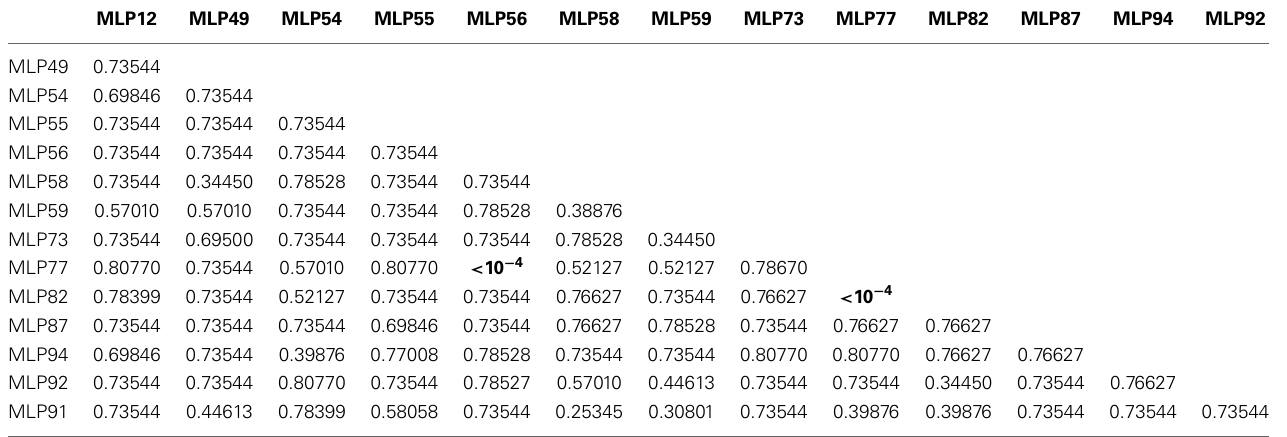
Table 2 | Matrix of Q -values for all pairwise linkage disequilibrium tests between microsatellite